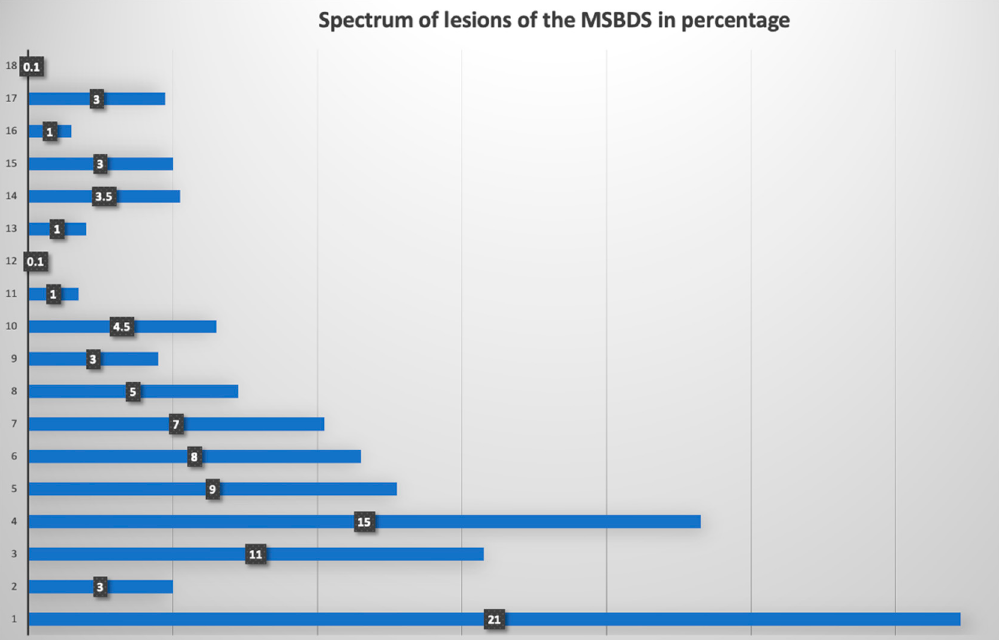
Figure 2. Frequency of bone lesions in the web-based reliability assessment. In this graph, the distribution of the degree of pathological findings, according to the MSBDS, is presented. The range of the MSBDSs was between 1 and 18. Most lesions (21%) were small lesions with an MSBDS of 1.